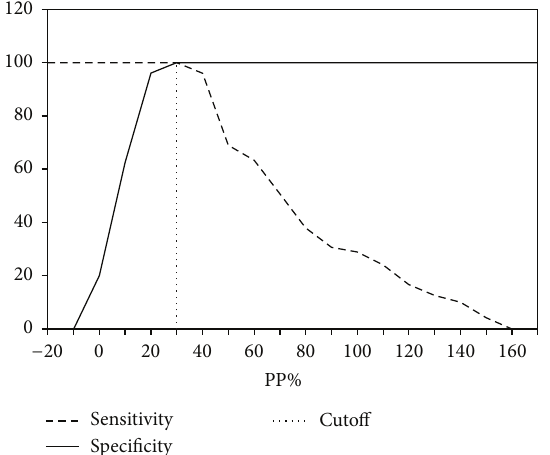
Figure 4: Determination of cutoff point of indirect enzyme-linked immunosorbent